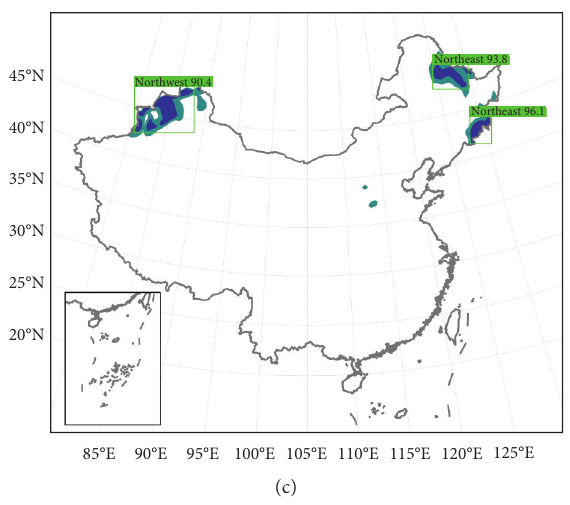
Figure 7: The effect of three models on mixed NITR